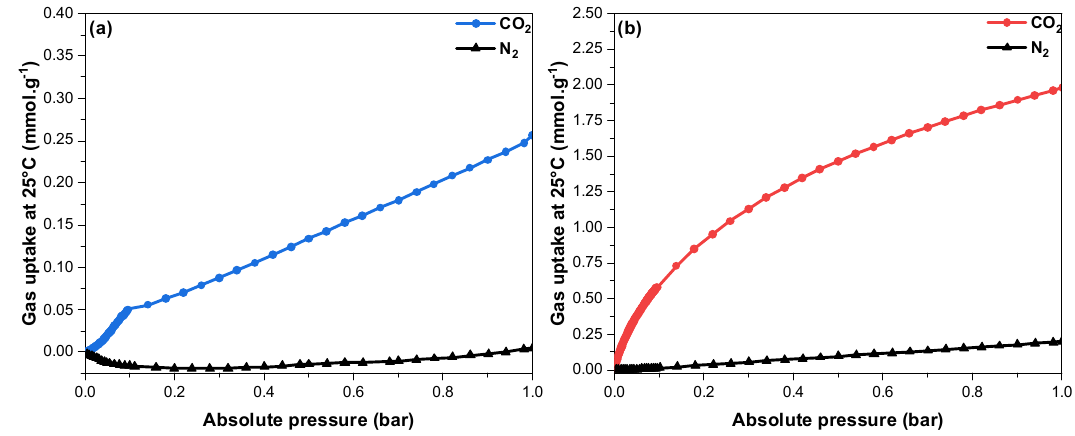
Figure 9. CO 2 and N 2 adsorption isotherms at 25 °C of ( a ) BCN − 1 and ( b ) BCN − 11. Many types of porous adsorbents have been studied for CO 2 adsorption. Wang et al. [61] published a well-detailed and exhaustive review paper reporting CO 2 capture performances of different solid adsorbents. Some examples are presented in Table S3. For instance, reported carbon-based materials (having high surface areas) had CO 2 uptakes between 0.5 mmol · g − 1 for CuO loaded porous carbon (at 25 ◦ C) [62] and 8.9 mmol · g − 1 for activated carbon spheres (at 0 ◦ C) [63] but relatively low selectivity [61,64]. For zeolites and silica-based materials, the strong interaction with the surface led to chemisorption of CO 2 , which consumes energy and thus disrupts their recyclability. MOFs are other candidates for CO 2 capture owing to very high surface areas (>1000 m 2 · g − 1 ) and controllable